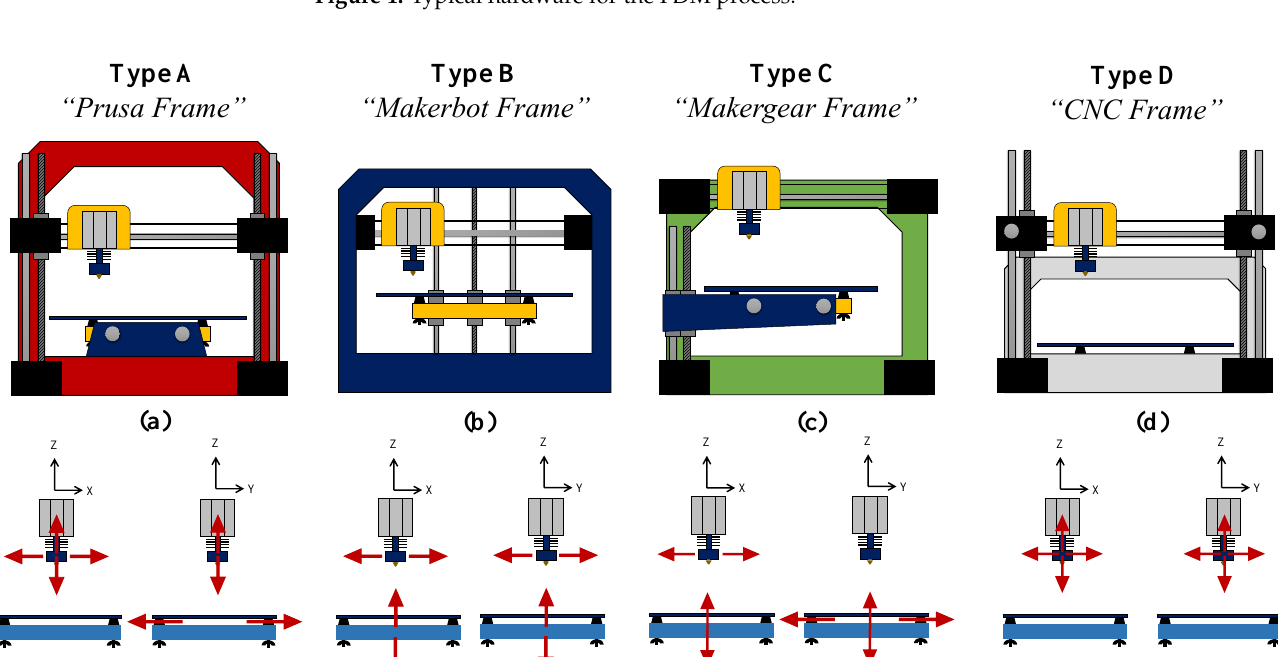
Figure 2. Most common 3-degree-of-freedom (DoF) hardware configurations (( a ) Prusa-type frame, ( b ) Makerbot-type frame, ( c ) Makergear-type frame, and ( d ) CNC-type frame), with the degrees of freedom for the extruder and build plate shown in each case. Others exist, such as those built around delta robots and higher-DoF robotic